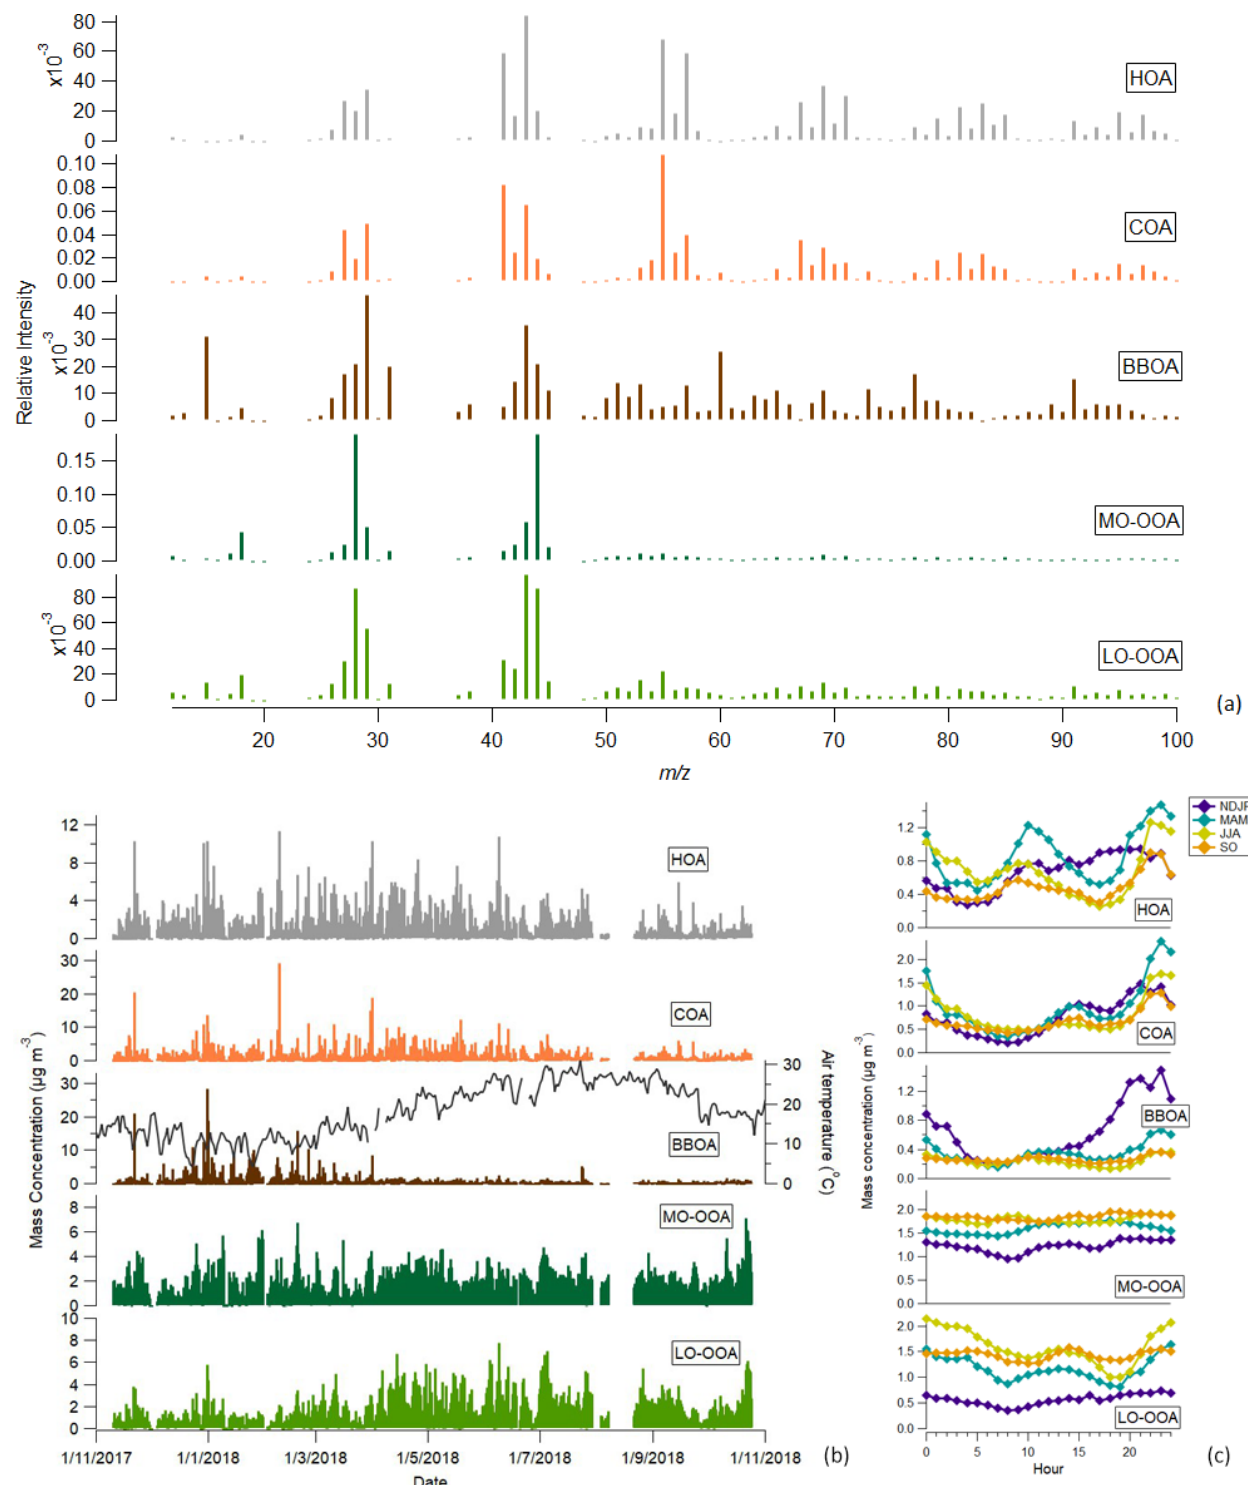
Figure 3. Mass spectra (a) , time series (b) and diurnal trends (c) of the five organic aerosol factors.